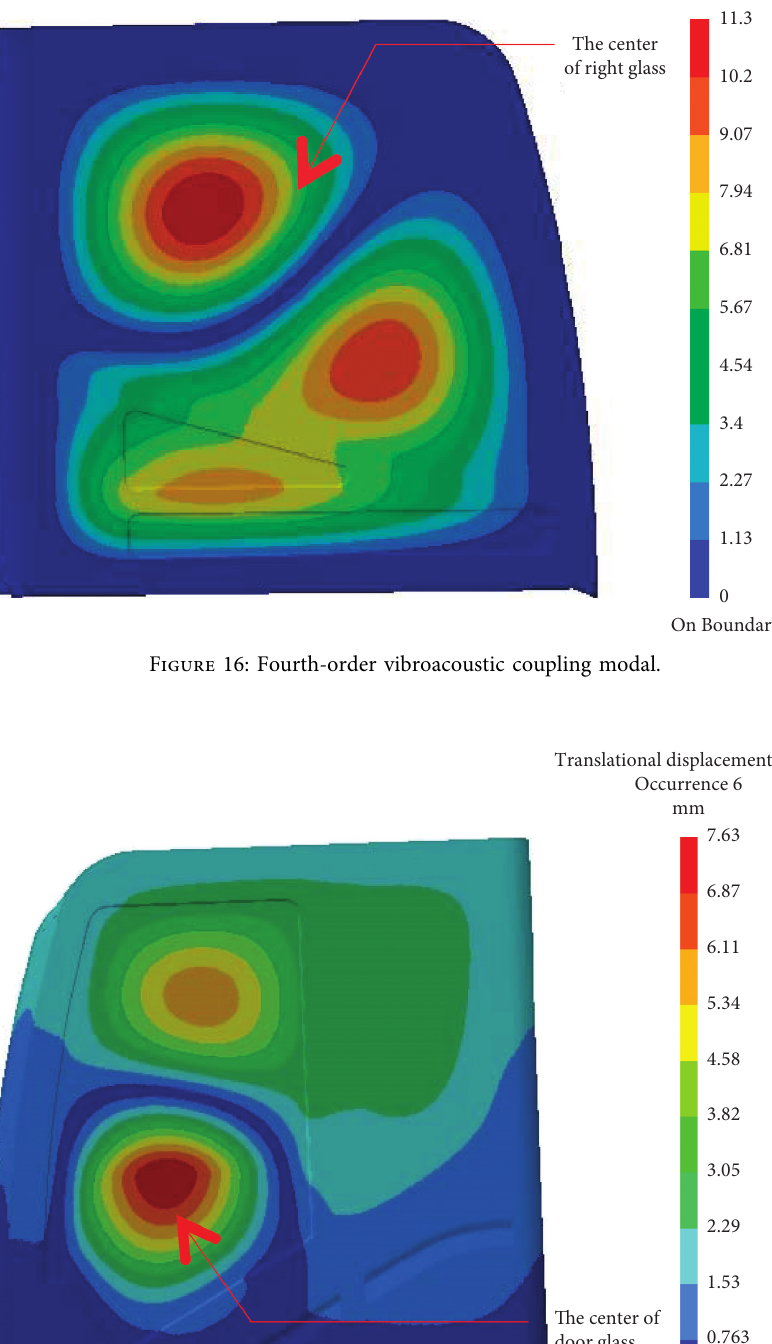
The center of door glass.